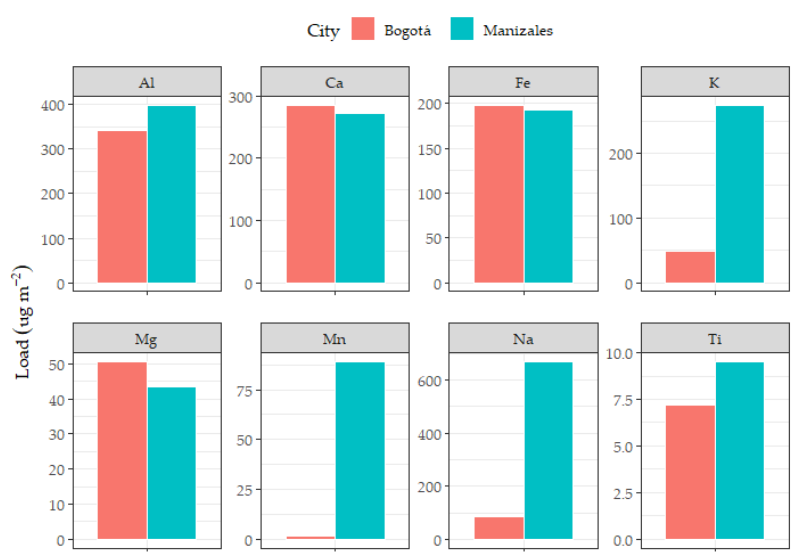
Figure 7. Individual load of main elements obtained in Bogotá and Manizales.